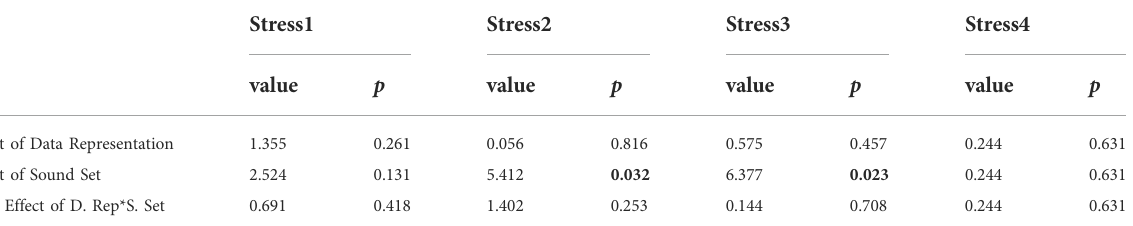
TABLE 9 Statistical analysis of stress data.